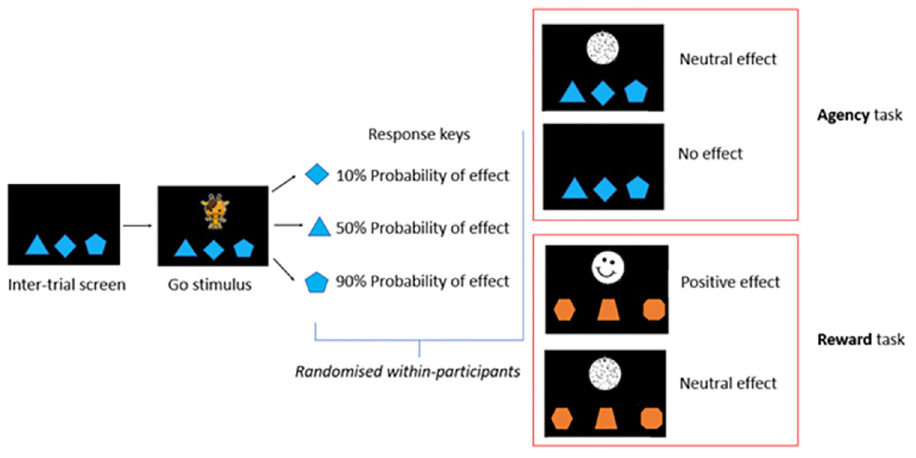
Fig 1. Agency and reward